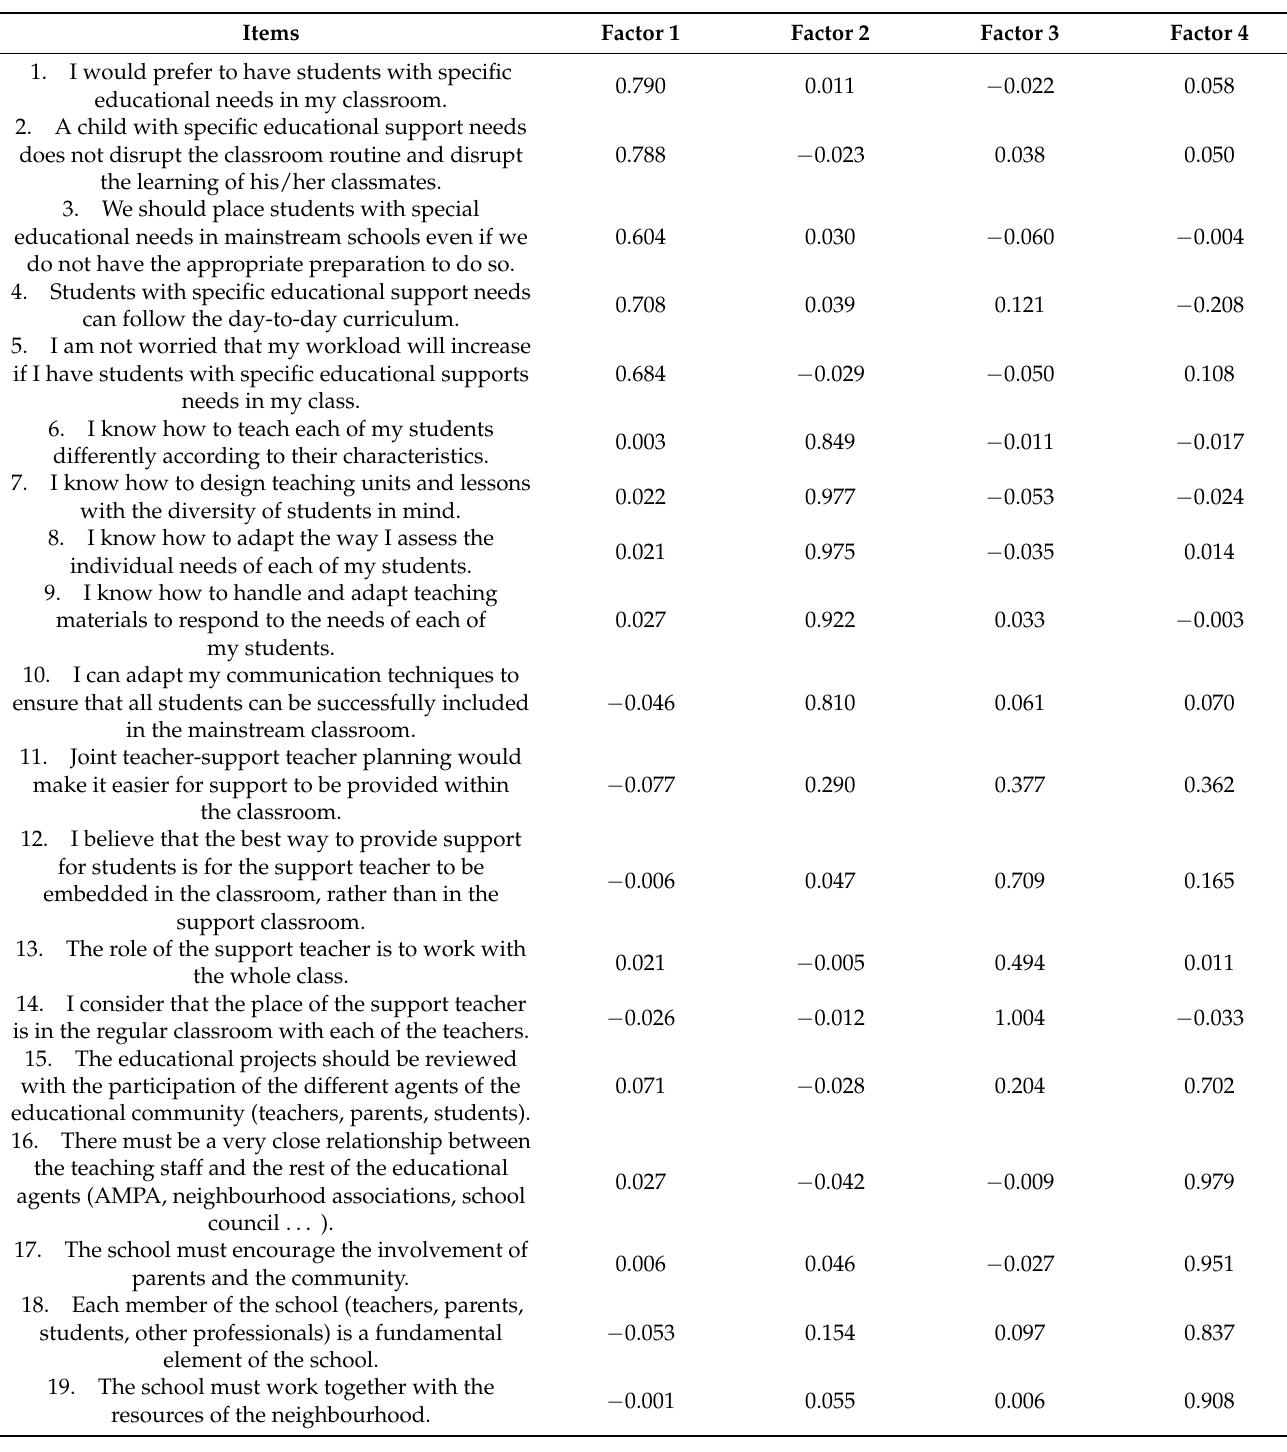
Table 2. Rotated loading matrix with Normalized Direct